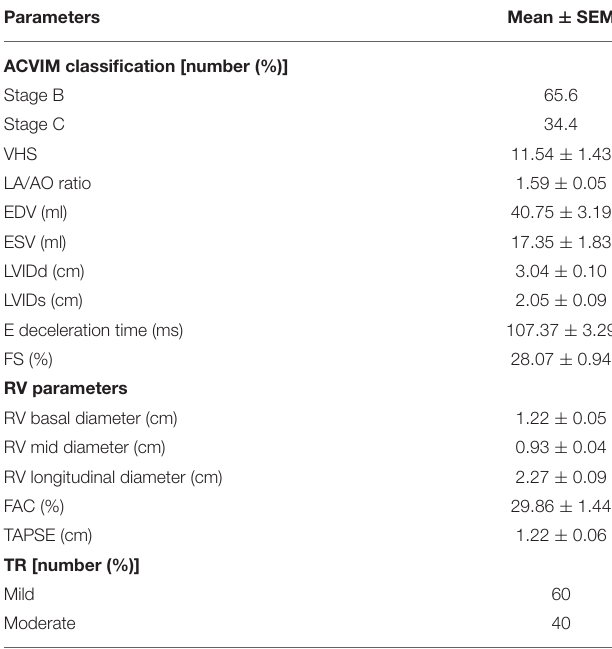
TABLE 1 | Characteristics and echocardiographic variables in 93